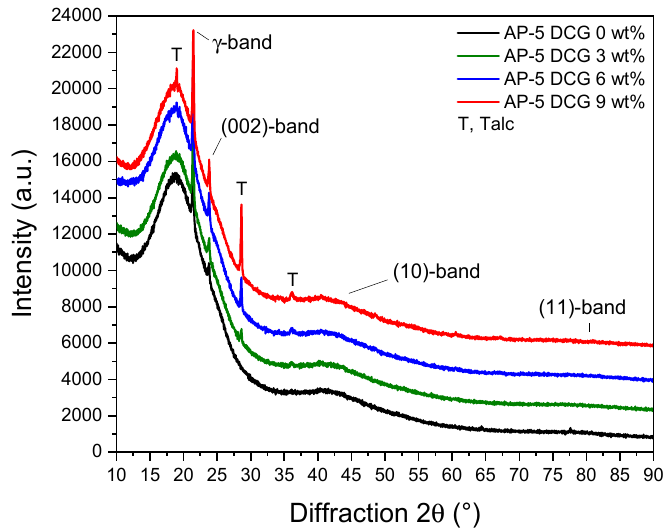
Figure 3. XRD patterns of base AP-5 asphalt and its samples including different doses of DCG (e.g., 3, 6, 9 wt%). 3.3. Thin-Layer Chromatography-Flame Ionization Detection (TLC-FID)